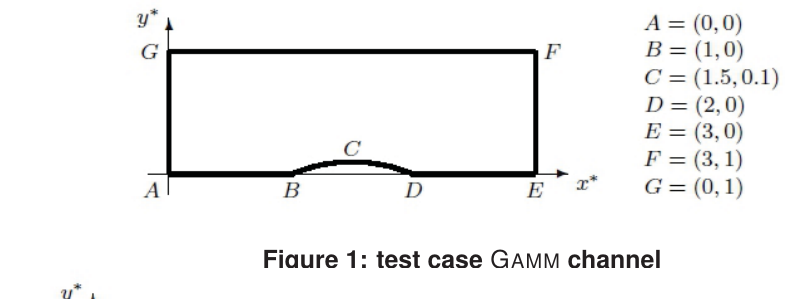
Figure 1: test case G AMM channel